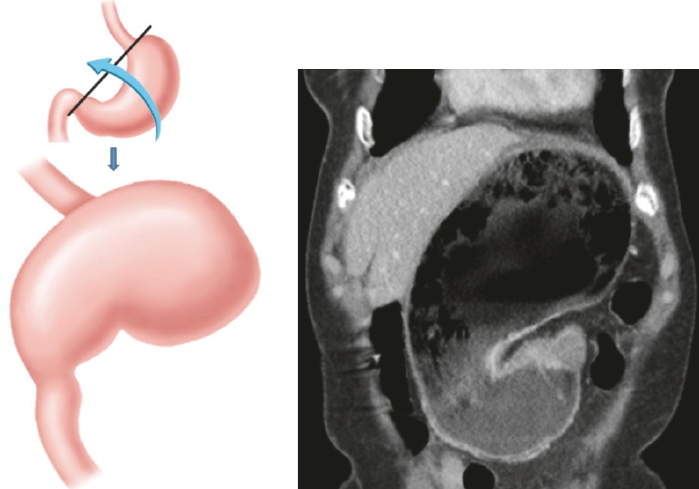
Figure 6: Organoaxial gastric volvulus. Rotation of the stomach along its long axis through a line that connects the gastroesophageal junction and the